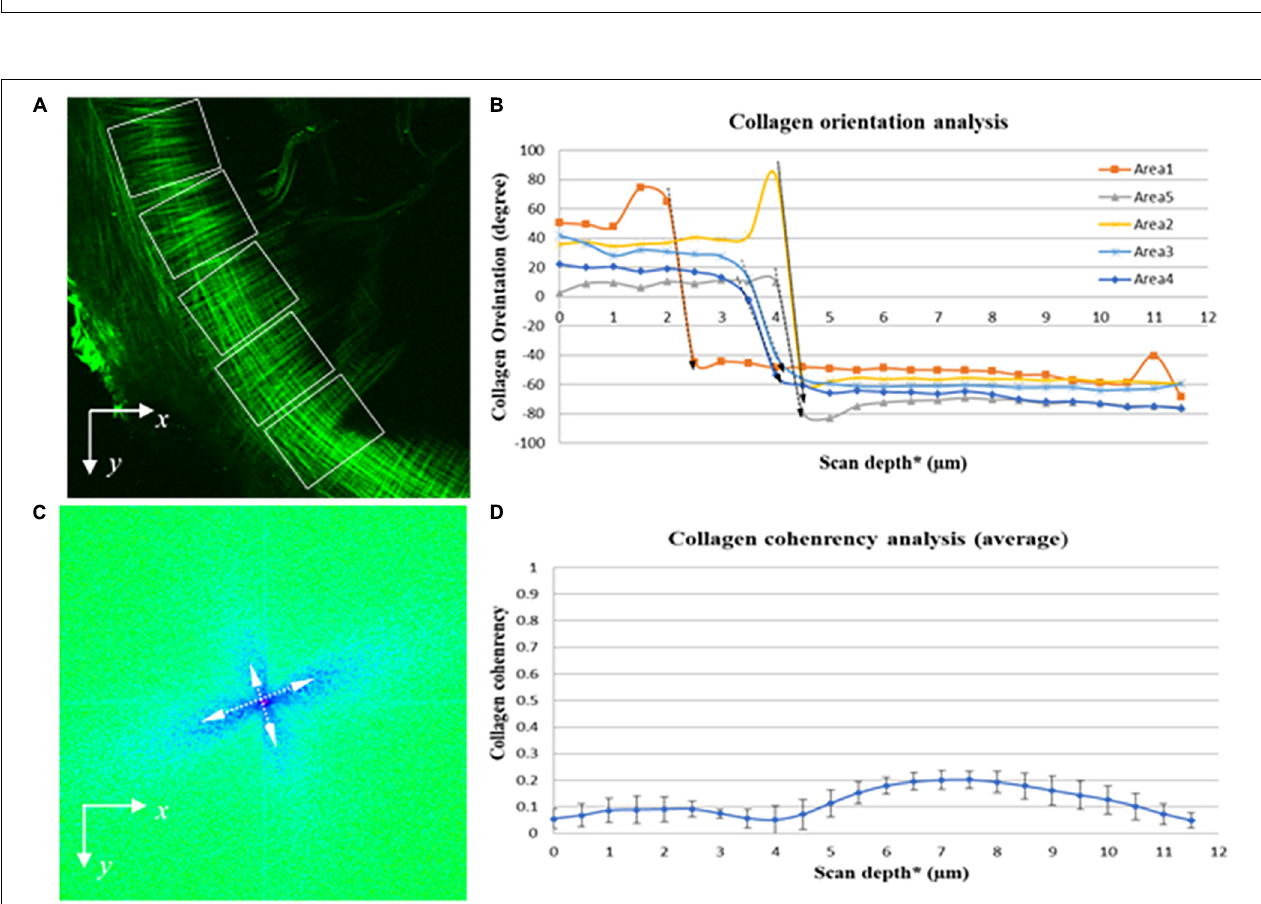
FIGURE 9 | Quantitative imaging analysis of the orientation and coherency of the collagen fibers in the pars tensa from the lateral to medial side. (A) SHG images were divided into five regions of interest (dashed boxes) to quantify the orientation and coherency of the collagen fibers comprising the parse tensa from the lateral to medial side. (B) Collagen orientation analysis confirms across the TM thickness the collagen fibers comprising the pars tensa sharply change their orientation (dash arrows highlight). (C) FFT analysis confirms that the collagen fibers composing the pars tensa orient into two distinctive directions approximately perpendicular to each other. (D) The coherency analysis shows that the collagen fibers comprising the pars tensa have a very low coherency value just below 0.2. *The collagen scaffold in the pars tensa is in a shallow conical shape so that the scan depth has been used in the orientation and coherency analysis of the collagen fibers but the entire scan depth does not equal to the thickness of the pars